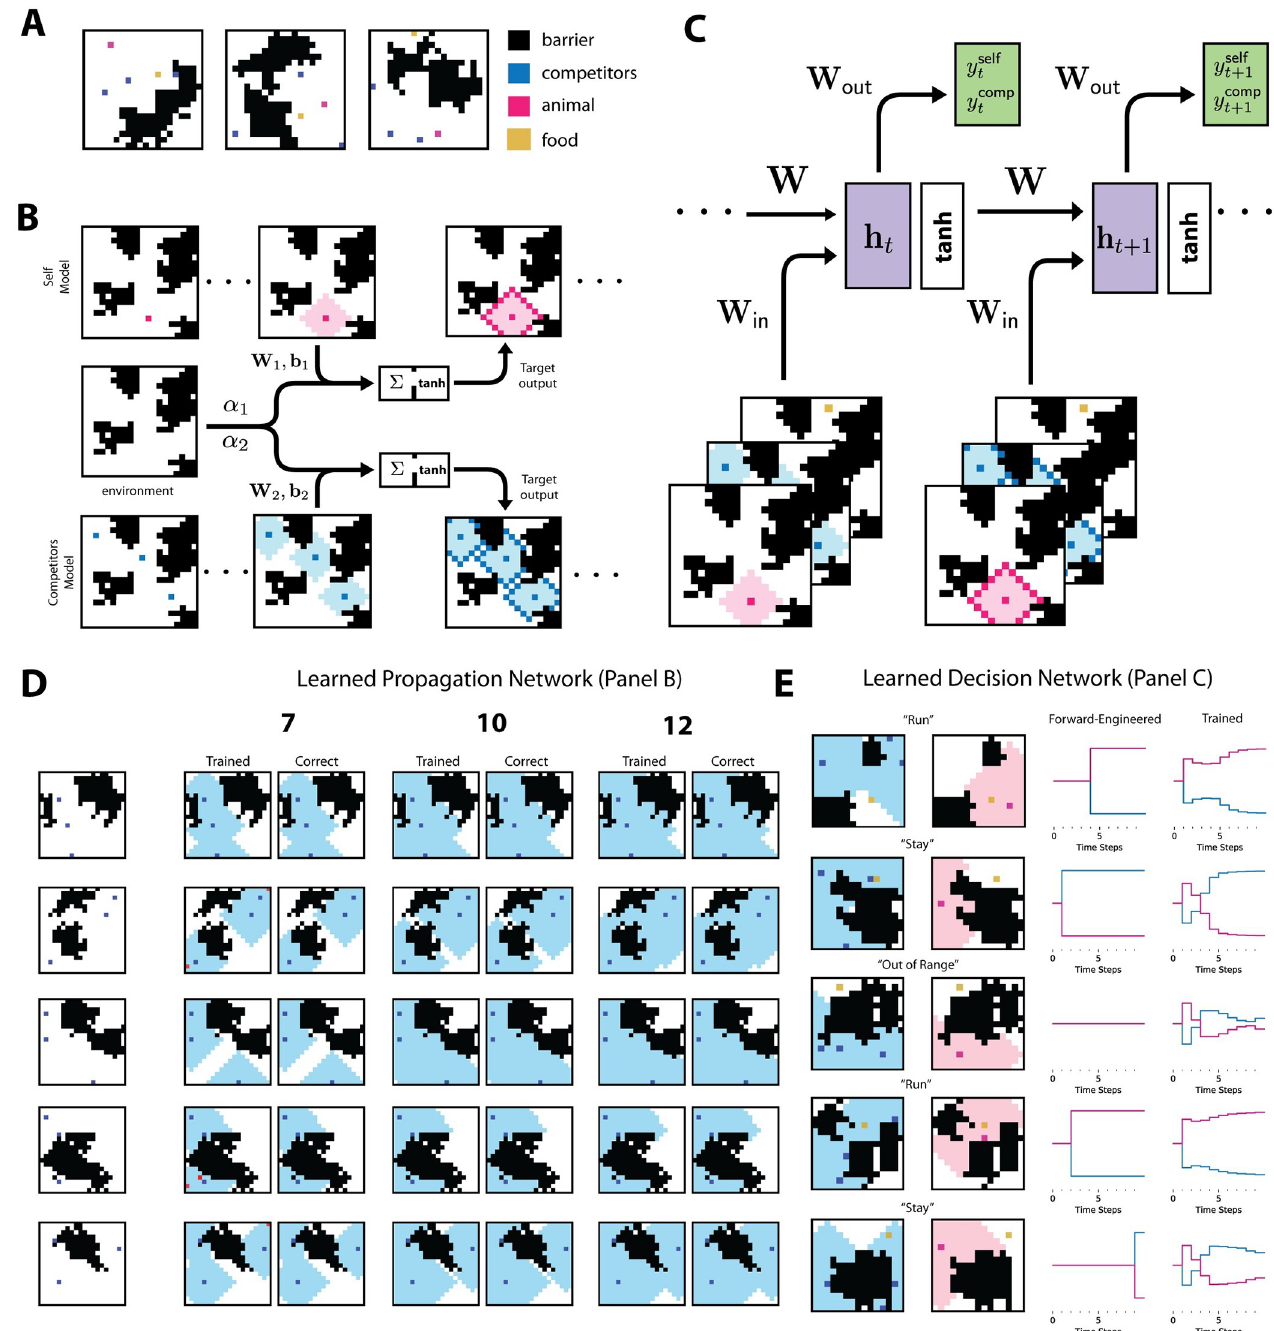
Fig 5. Competitive Foraging Task. (A) Randomly generated examples of the competitive foraging task. (B) The animal’s and competitors’ propagation networks. Each one implements the tag-propagation algorithm with open space pixel corresponding to on pixels and barriers corresponding to off pixels. Unlike the edge-connected pixel task, the source pixels change in every sample to correspond to the location of the animal and its competitors respectively. See Methods for further implementation details. (C) Architecture for the trained decision network. The time series of animal and competitor ranges are concatenated with the food pixel and then are used as the input to a recurrent network. The decision traces shown in panel E are the projection of the trained network onto the two-dimensional readout. (D) Sample outputs for the trained propagation networks. These are the best networks trained with 7, 10, and 12 layers respectively. Errors in the trained network are marked in red. We show results only for the competitors’ network as the propagation task is the same for both the animal and its competitors; only the input which corresponds to the initial location changes. (E) The generalized tag propagation implements a correct version of the decision trace and is described in the Methods. For comparison, we show the decision trace outputted by the trained decision network. Propagation is shown after ten time steps, and each example is labelled with the correct decision after ten steps: “stay,” “run,” or “out of range.” Note that if the food location is in the range of both groups of animals, the decision is based on which animal can reach the food first. https://doi.org/10.1371/journal.pcbi.1010227.g005 PLOS Computational Biology | https://doi.org/10.1371/journal.pcbi.1010227 June 21,